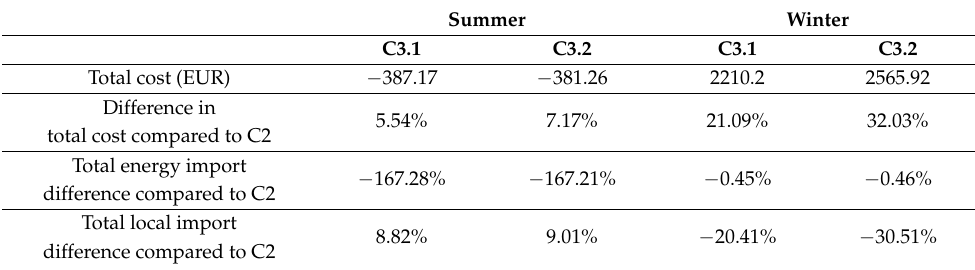
Table 4. The C3 results and a comparison to the C2 results.